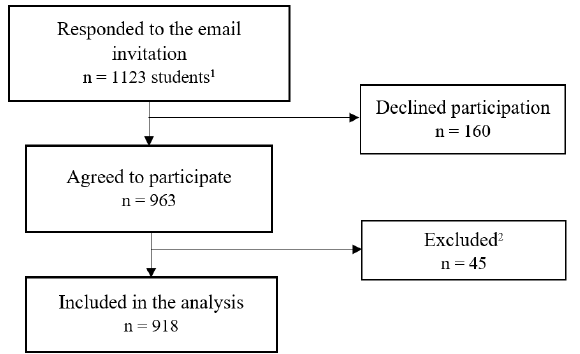
Figure 1. Flow chart of students’ responses from the three participating universities. 1 From the United Arab Emirates University, University of Sharjah, and Zayed University. 2 Reason for exclusion: consented but did not proceed with the survey ( n = 41) and consented but did not report on their tobacco smoking status ( n = 4). Table 1. Characteristics of participating students by their current smoking status (smoker, non-smoker). Characteristics